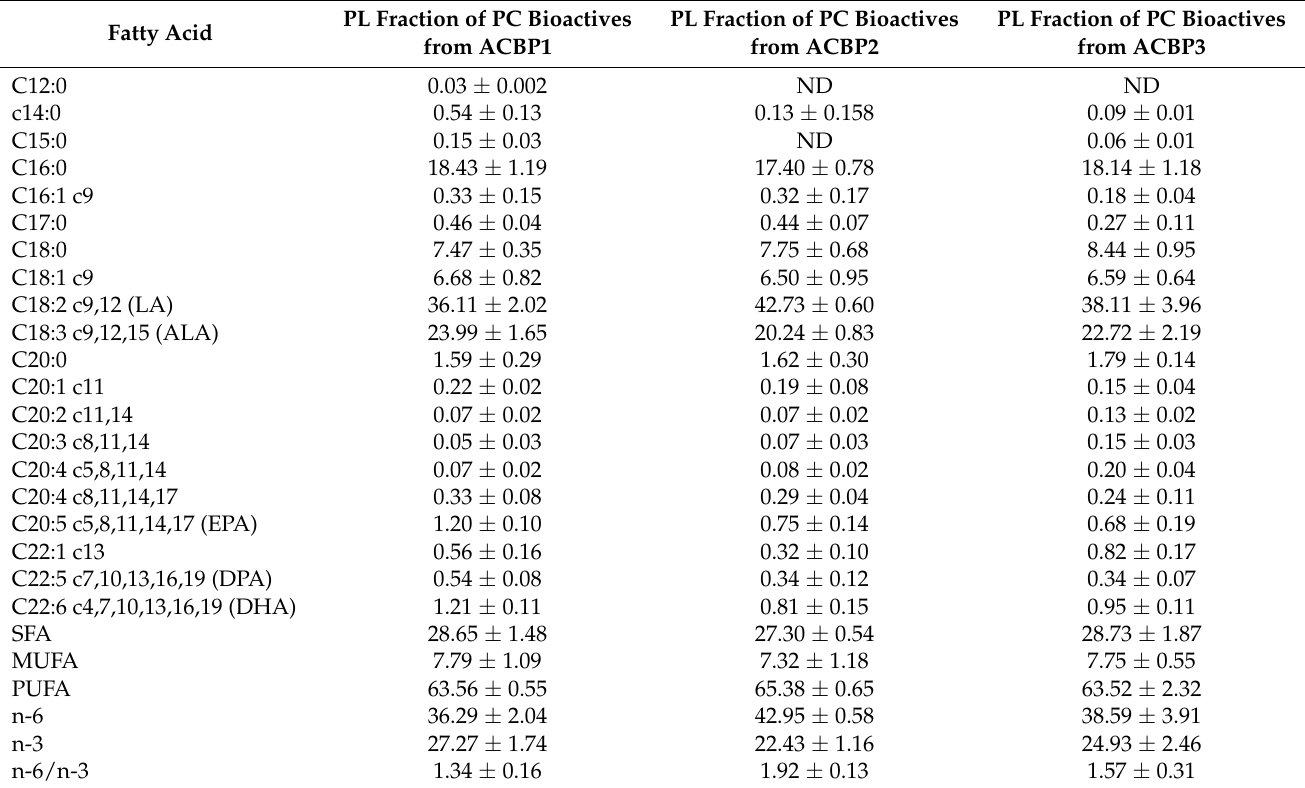
Table 4. The fatty acid profile of PL fraction 3 containing the PC bioactives of each ACBP apple pomace, expressed for each FA as the mean value of its % percentage in the total fatty acids of each sample assessed (mean ± standard deviation (SD), n = 3). PL Fraction of PC Bioactives PL Fraction of PC Bioactives PL Fraction of PC Fatty Acid from ACBP1 from ACBP2